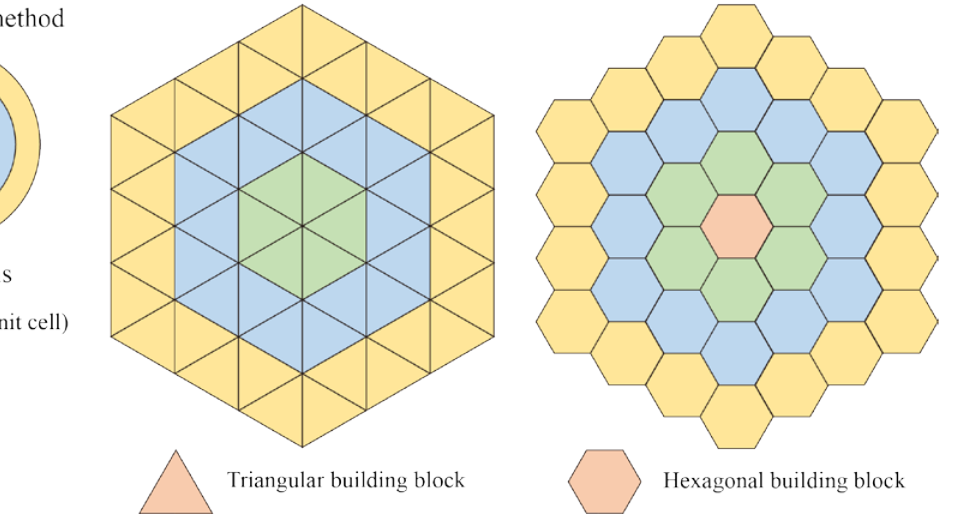
Figure 4. Lattice structure constructed with the circular array method. (Note: the triangle type does not have the centered cell of N = 0.).